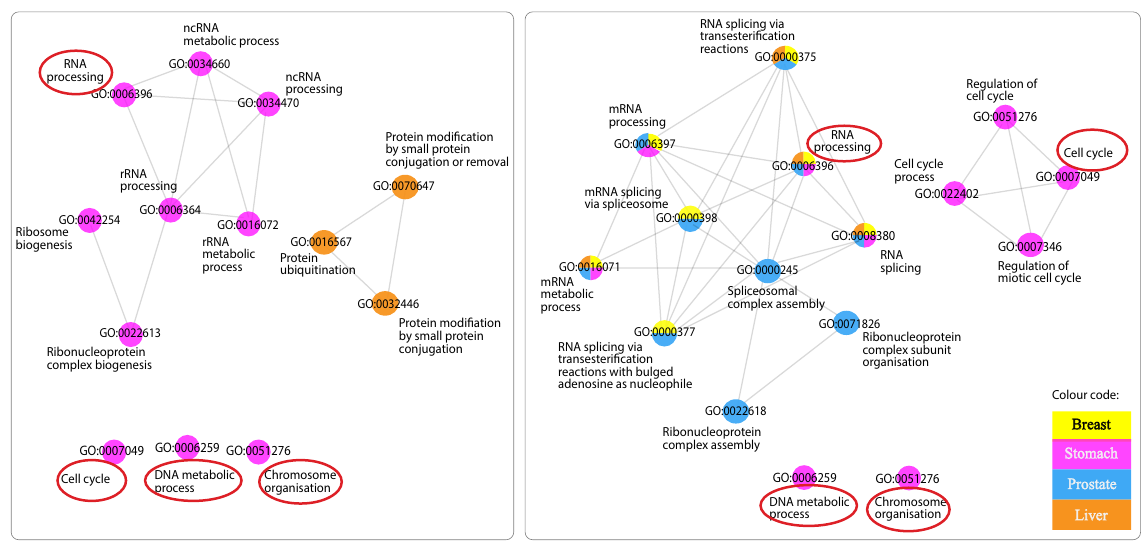
Figure 5. Comparison of Antisense and Divergent GO terms similarity networks. Similarity networks among GO terms enriched by mRNAs related negatively to Antisense (left) and mRNAs related positively to Divergent (right). Shared GO terms in both networks are encircled in